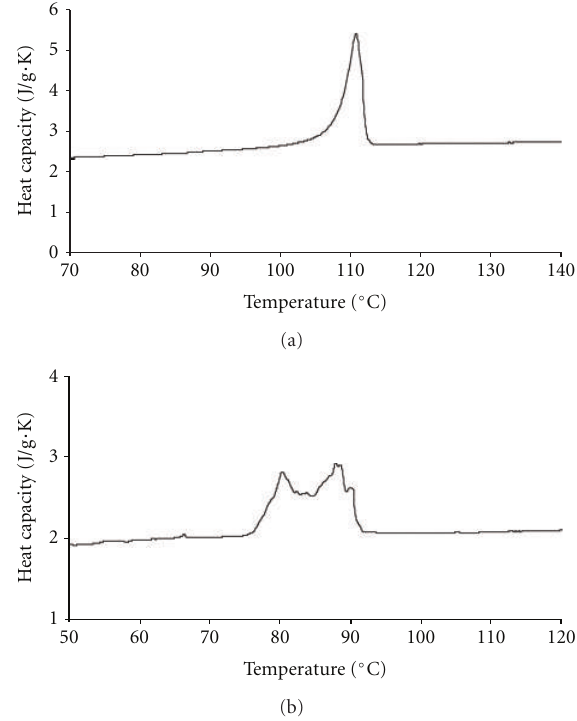
Figure 11: DSC thermograms for cholesteryl acetate dispersed in UV15 at scanning rate of 10K · min − 1 , (a) heating, (b)